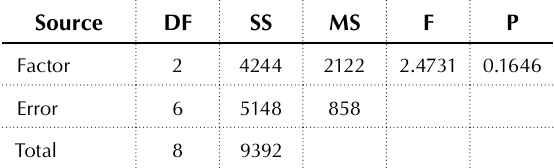
Table 7. The obtained data